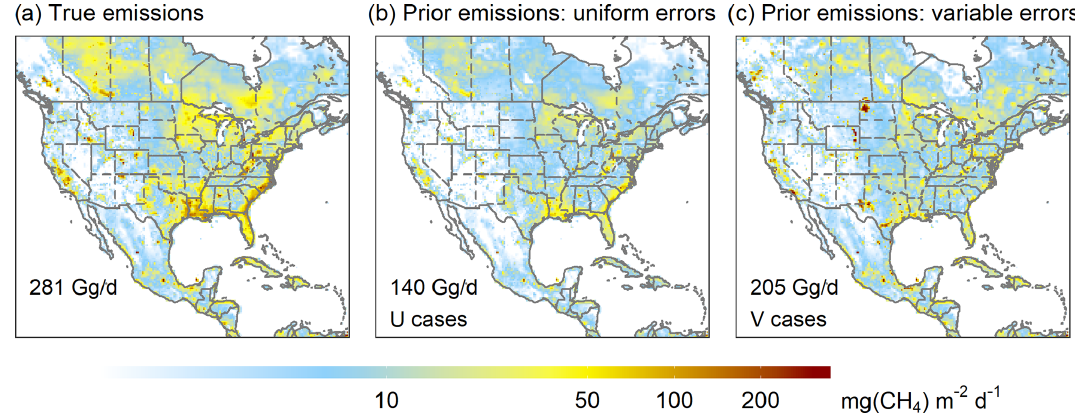
Figure 3. True-state and prior emissions used in the OSSE analyses. The total emission for the North American domain is labeled in each